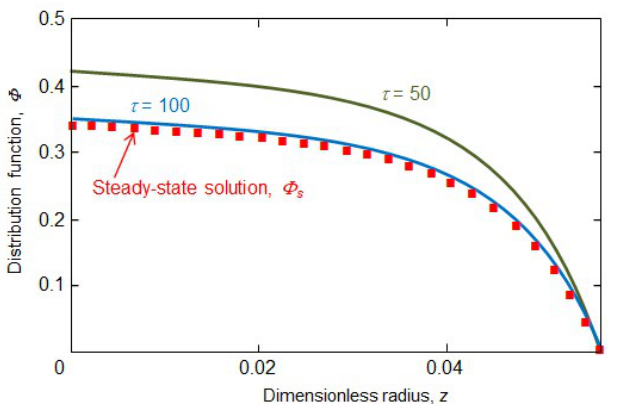
Figure 5. Particle-radius distribution function Φ ( z , τ ) versus dimensionless radius z accordingly to the analytical solutions (44) and (55). Here Q 0 = 0.005 and w s = 0.349. The steady-state distribution function Φ s ( z ) (red squares) is plotted accordingly to the analytical solution